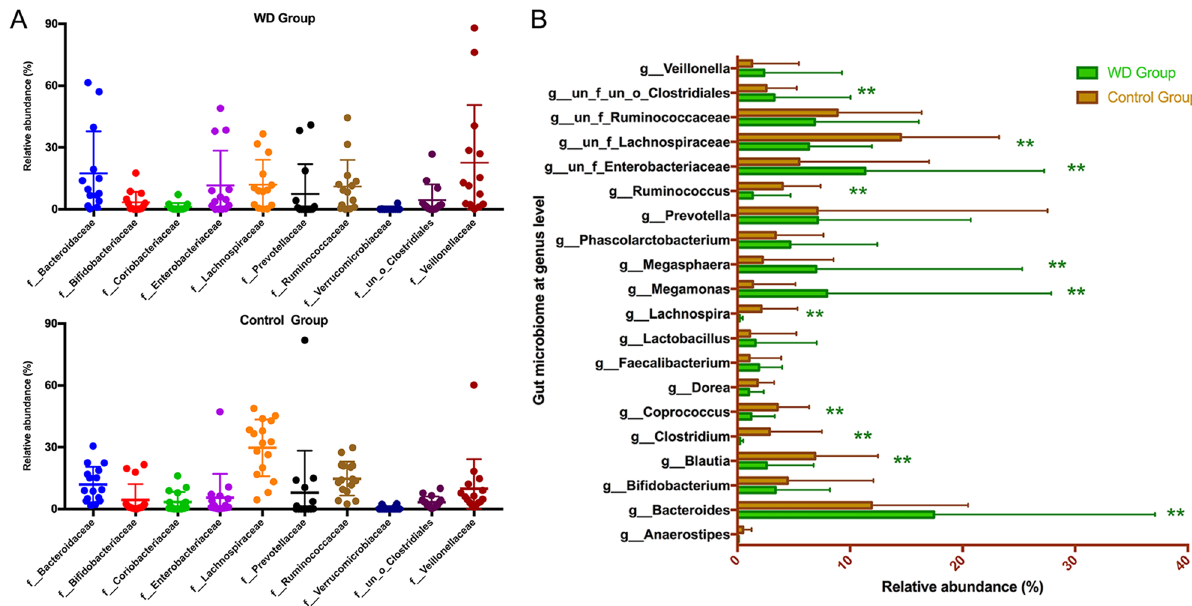
Figure. 3. ( A ) Comparison of abundant components of the microbiome at the family level between the two groups. ( B ) Taxonomic summary of the gut microbiota of each group at the genus level. Bacteroides , Enterobacteriaceae , Megamonas and Megasphaera were significantly more abundant in the WD group than the control group ( P < 0.05). Lachnospiraceae , Ruminococcaceae , Blautia , Ruminococcus , Coprococcus Clostridium and Lachnospira of WD group were significantly less abundant in the WD group than the control group ( P < 0.05). Starred samples (*) showed significant differences between the two compositions of the two groups were highly similar, the gut microbiome in WD patients showed a less richness in pathways of transcription factors and ABC-type transporters than healthy controls ( F = 31.745, P < 0.001). The analysis indicated the clustering of metabolic modules were decreased in WD group including metabolism of fructose ( F = 31.2291, P < 0.001), mannose ( F = 28.745, P < 0.001), butanoate ( F = 31.385, P < 0.001), glyoxylate and dicarboxylate ( F = 30.7384, P < 0.001), interconversions of pentose and glucuronate ( F = 32.6781, P < 0.001), other ion-coupled transporters ( F = 31.4571, P < 0.001), and carbon fixation in photosynthetic organisms ( F = 30.6242, P < 0.001) (Fig. 6A). In addition, the TRAP-type C4-dicarboxylate transport system, periplasmic component ( F = 38.397, P < 0.001), dihydroxyacetone kinas ( F = 37.2417, P < 0.001), TRAP-type C4-dicarboxylate transport system, small permease component ( F = 37.5488, P < 0.001), and TRAP-type C4-dicarboxylate transport system, large permease component ( F = 36.4327, P < 0.001) were all significantly less abundant in the WD group than in